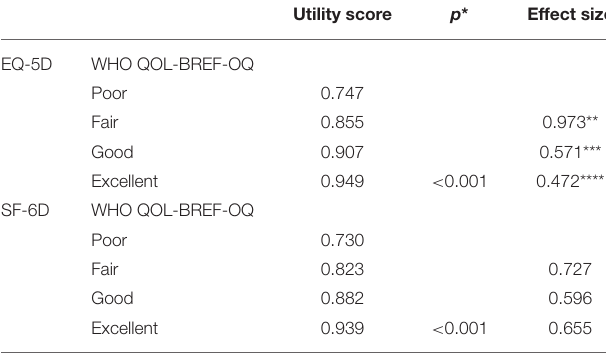
TABLE 3 | Discriminant capacity of EQ-5D and SF-6D utility